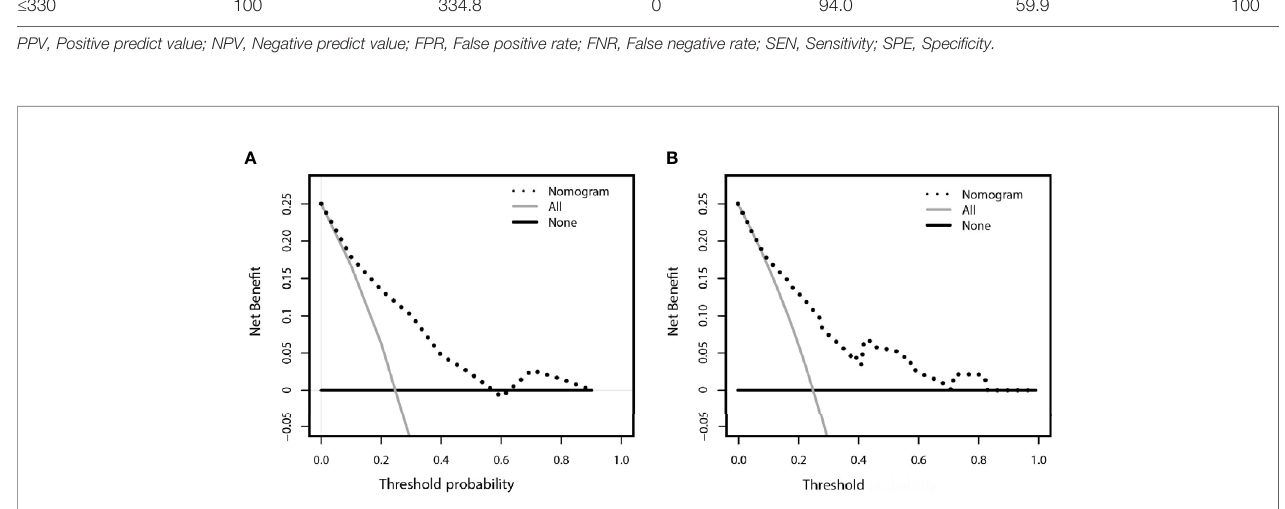
FIGURE 5 | Decision curve analysis comparing the net-bene fi t of using the nomogram (black clashed line) depicted in (A) training set (B) validation set. Black solid line: net bene fi t when all breast cancer patients are considered as not upgrade with ADH; gray solid line: net bene fi t when all ADH patients are considered as upgraded to breast cancer. The ideal model is the model with highest net bene fi t at any given threshold.